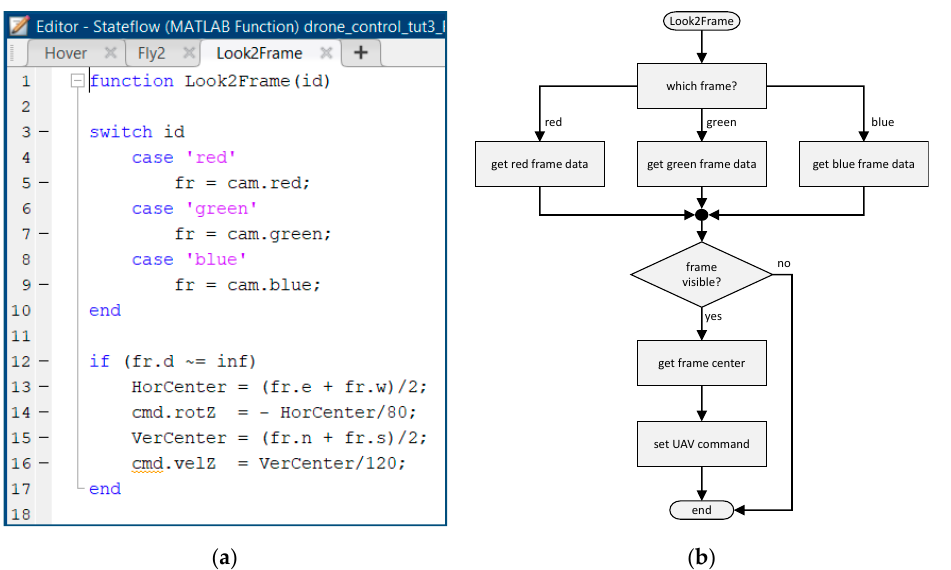
Figure 13. Look2Frame MATLAB function defined in Figure 7: ( a ) implementation; ( b ) flow chart. In the Crossing state, the quadcopter is correctly oriented in front of the frame, at 30 cm. All lateral movements are stopped, and a moderate forward velocity is applied. Given the distance to be covered and the speed applied, after 4 s the quadcopter should have passed through the frame. Note that, if possible, the drone continues to make corrections to keep the frame centered on the camera image. Finally, the frame disappears from the camera’s field of view, and the drone advances “blindly” for the last stretch. After crossing, the drone rises for 2 s to move away from the plane of collision with the frame. The superstate then changes to the End state, and the navigation system moves to the Landing superstate. The implementation of the Landing superstate is shown in Figure 14.